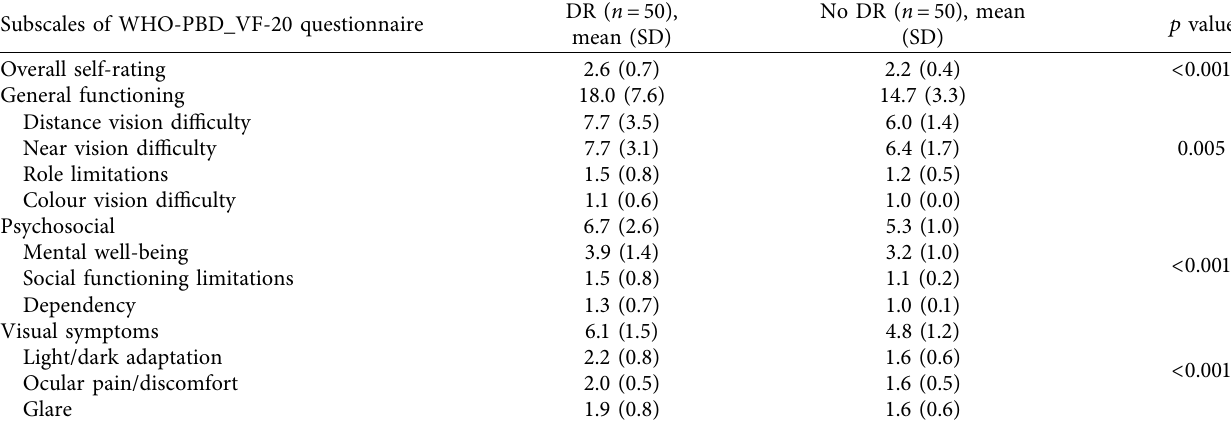
Table 3: Vision-related quality of life mean scores among patients attending the diabetes and eye clinics. Subscales of WHO-PBD_VF-20 questionnaire